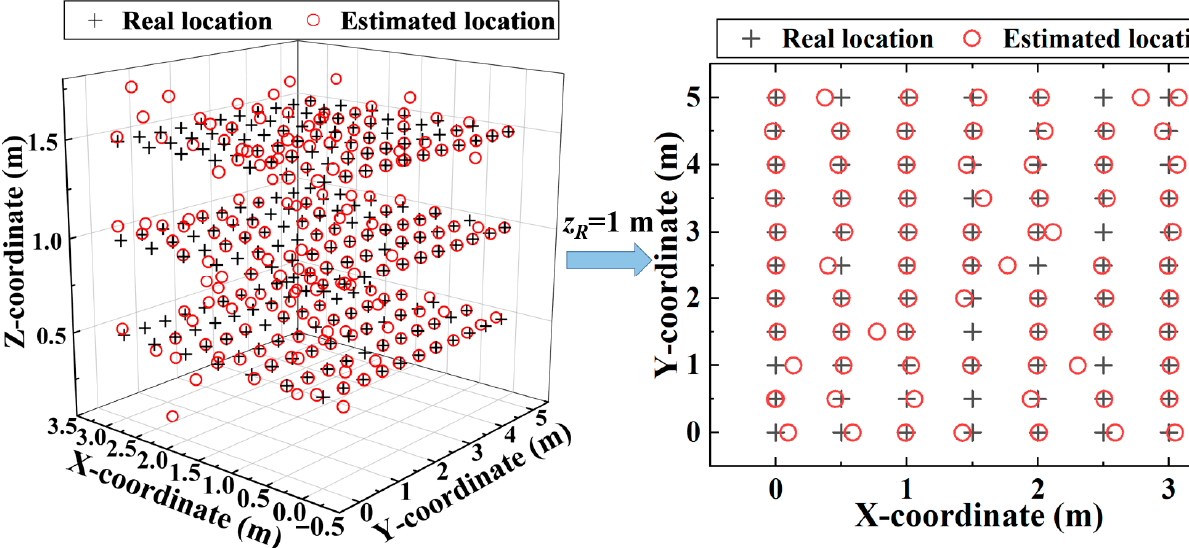
Figure 4. CDFs of 3D positioning errors at (0.5, 1, 1). ( θ = 0°).